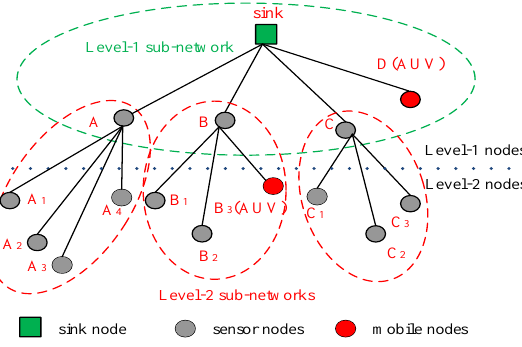
Figure 1. The network topology of the two-tier underwater acoustic sensor network (UASN) for data collection.